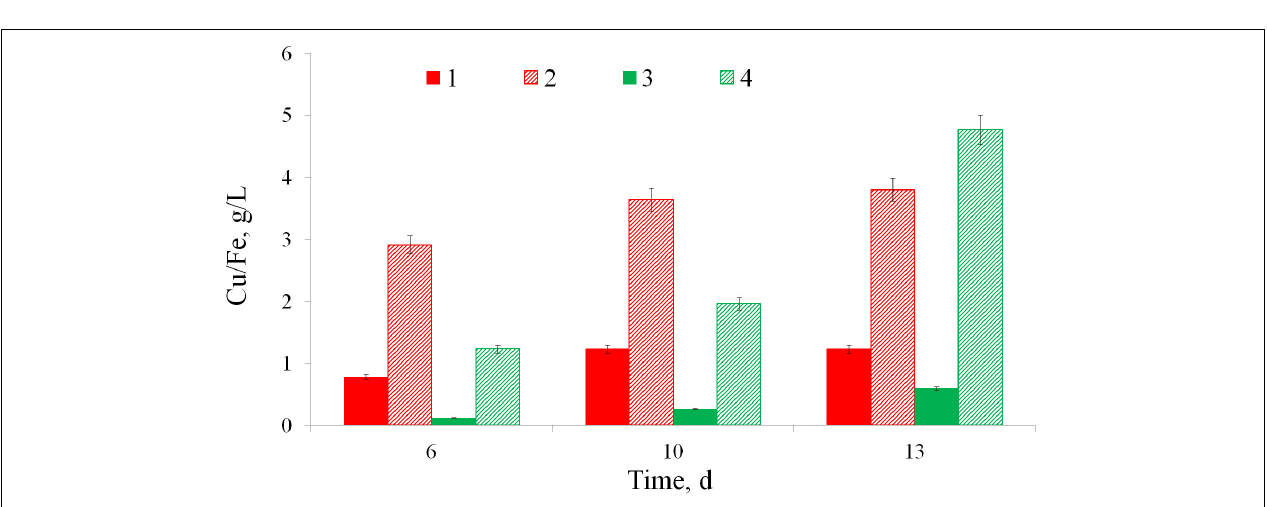
FIGURE 3 | Bioleaching of iron (1, 2) and copper (3, 4) from a copper ore without bacteria (1, 3) and by At. ferrooxidans Ksh (2, 4) (pulp density 10%, temperature 35 ◦